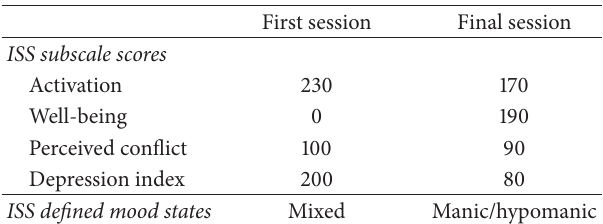
Table 1: Internal State Scale (ISS) subscale scores and mood states at first and final psychoeducation